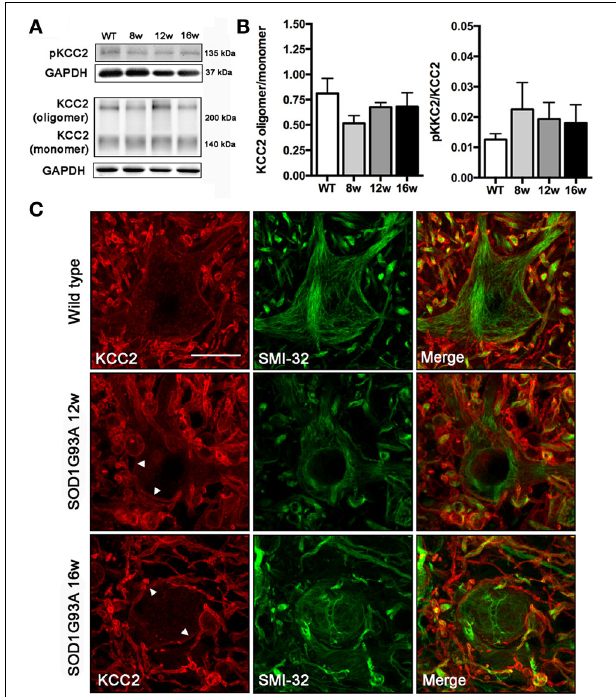
FIGURE 2 | Analysis of KCC2 and phopho-KCC2 expression in the ventral spinal cord of SOD1 G93A mice at 8, 12, and 16 weeks of age. (A) Representative blots of phopho-KCC2 and total KCC2 (on both monomeric and oligomeric states). (B) KCC2 western blots quantifications. Graphs represent the ratio between the oligomeric KCC2 (functional state) vs. monomeric KCC2 and the phopho-KCC2 (active form) vs. monomeric KCC2. Note the lack of significant differences between SOD1 G93A at any age and wild type littermates. Data are represented as mean ± s.e.m. (C) Confocal images of wild type and SOD1 G93A L4 spinal MNs confirmed the maintenance of membrane-bound (active) KCC2 in transgenic animals along disease progression, even in abnormal MNs at 16 weeks of age. Arrowheads show the membrane bound KCC2 in SOD1 G93A L4 spinal MNs. Scale bar 20 µ